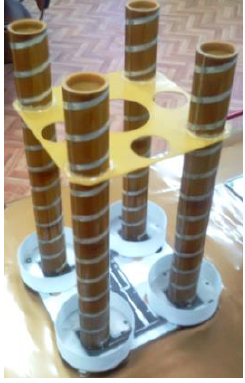
Fig 3. The on – board helical antenna